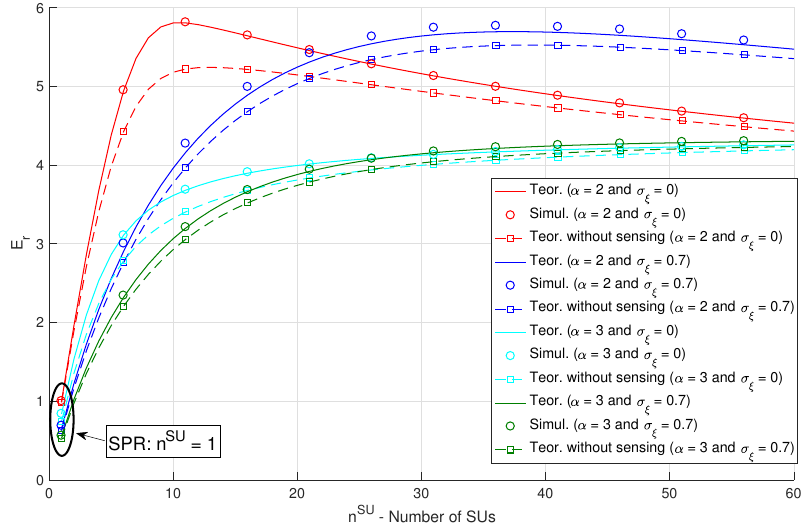
Figure 3. Average number of received packets ( E r ) given n SU transmitters, different values of α , and with or without fading. The SPR case is highlighted in the figure with the rectangle “ SPR : n SU = 1”.